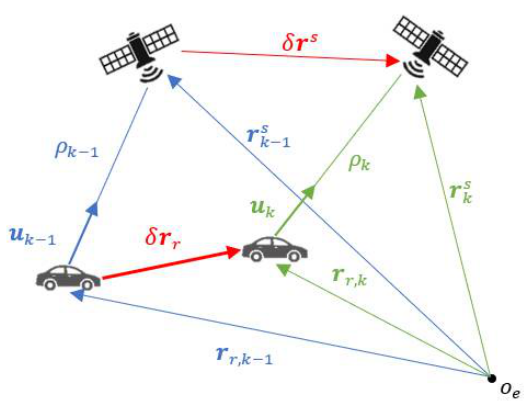
Figure 2. Geometrical relationship of the same receiver–satellite pair at two consecutive epochs k and k − 1, where o e denotes the origin of the e -frame.